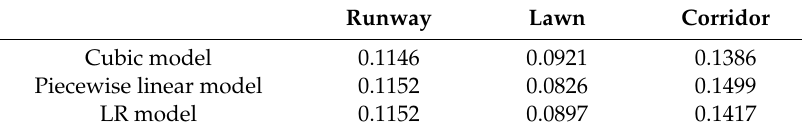
Table 6. RMSEs of LQI based mapping model in different environments.